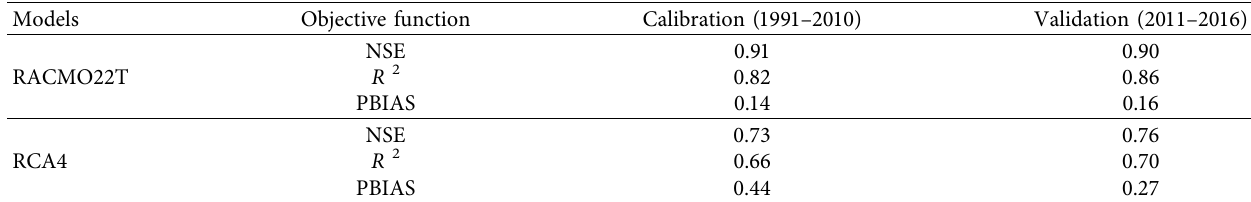
Table 6: Evaluation of RCMs performances by objective function directly from SWAT output. Models